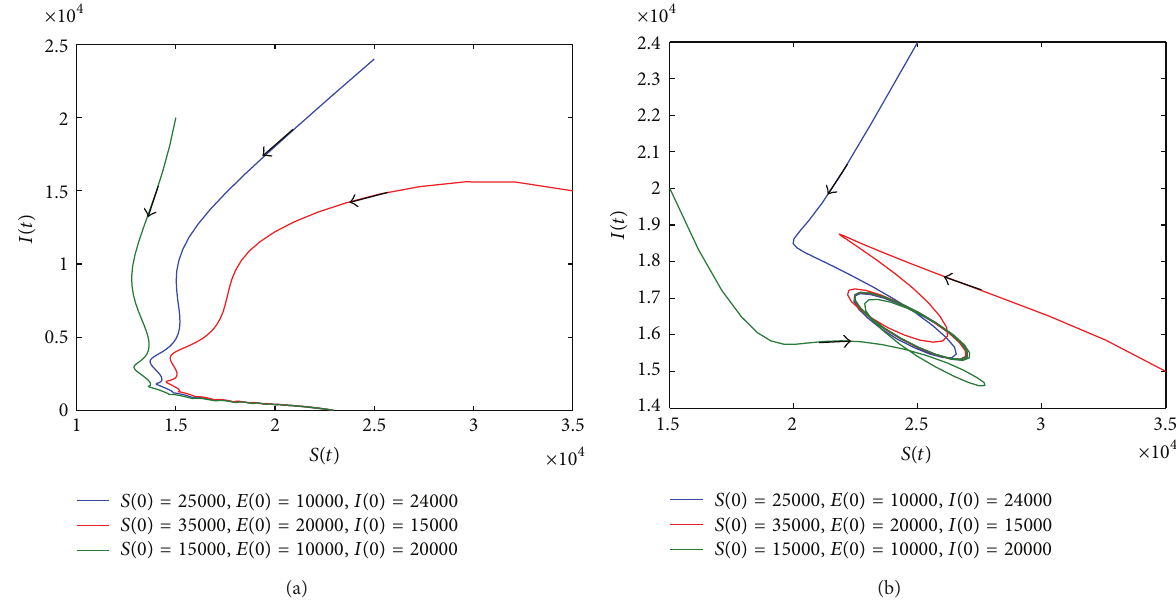
Figure 3: Phase plane of 𝑆(𝑡) and 𝐼(𝑡) . (a) When the parameter values are 𝑟 = 0.13 , 𝑎 = 0.3 , and 𝑏 = 0.2 , 𝑅 0 = 0.9029 < 1 , 𝑅 𝑑 = 1.3 > 1 . (b) When the parameter values are 𝑟 = 0.3 , 𝑎 = 0.7 , and 𝑏 = 0.2 , 𝑅 0 = 2.1067 and 𝑟 > 𝑚+𝜇 . The value of other parameters can be seen in Table